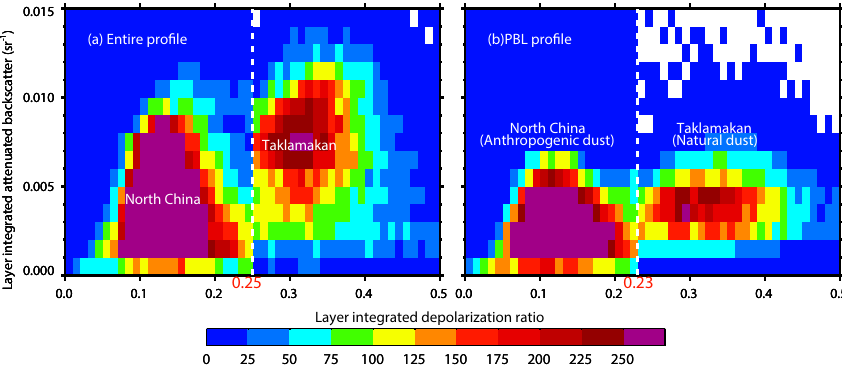
Figure 3. The relationship between the layer-integrated depolarization ratio and the layer-integrated attenuated backscatter coefficient for anthropogenic dust (North China) and natural dust (Taklamakan) for (a) the entire profile, and (b) the PBL profile.